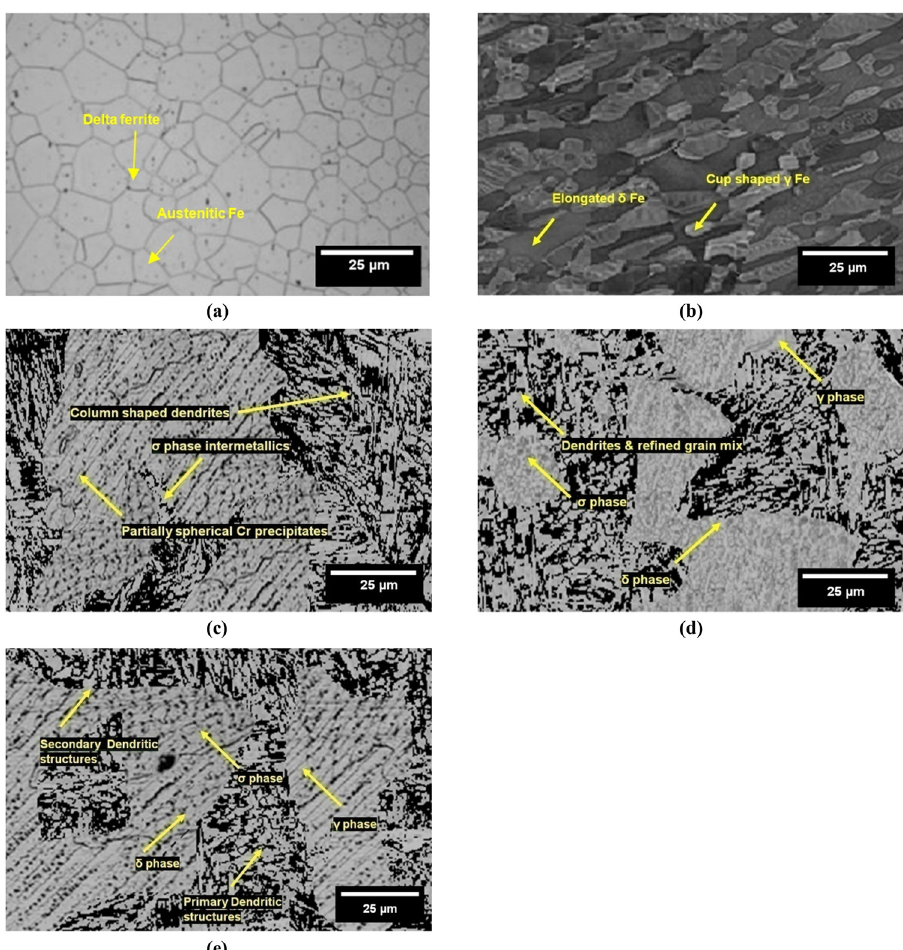
Figure 7: SEM images of ( a ) as - received AISI 310 SS, ( b ) as - received AISI 2205 DSS, and weld region of ( c ) W - A, ( d ) W - 3C, and ( e ) W -